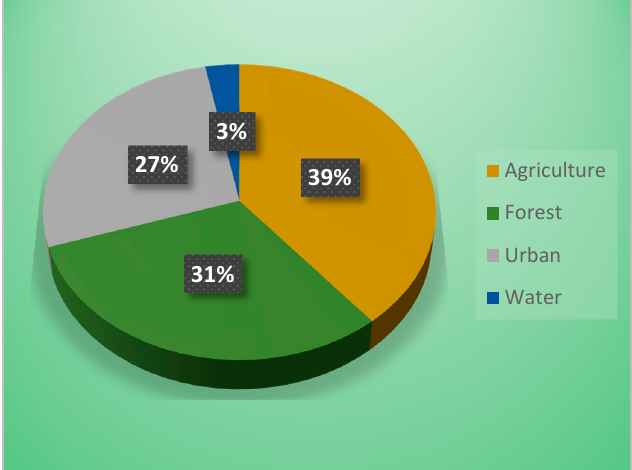
Figure 12. Liberty watershed land use distribution.